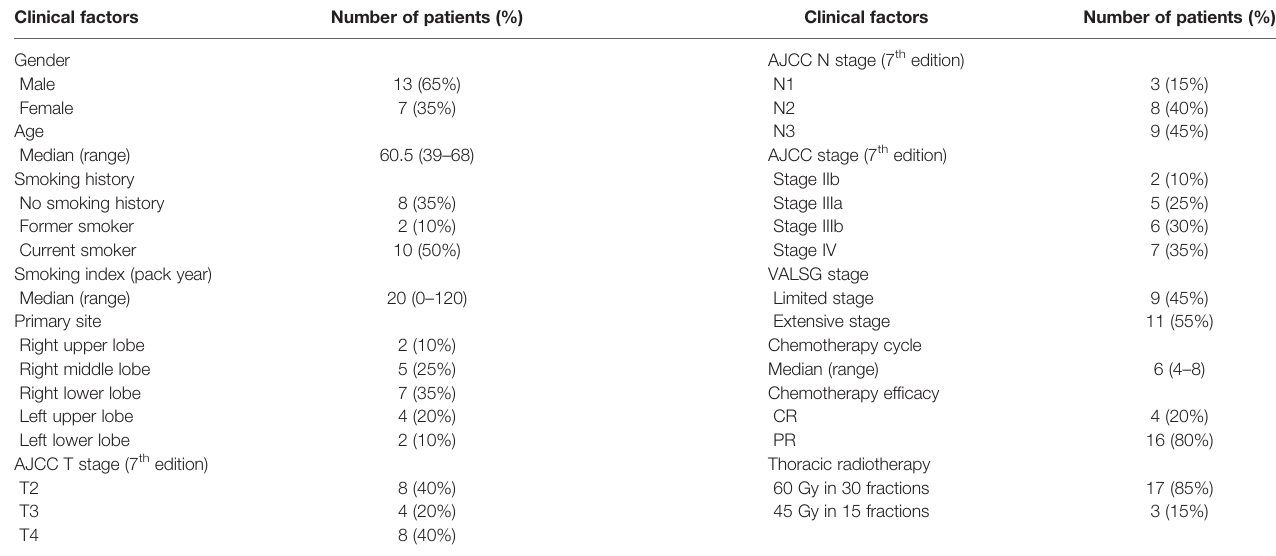
TABLE 1 | Baseline and clinical characteristics of the